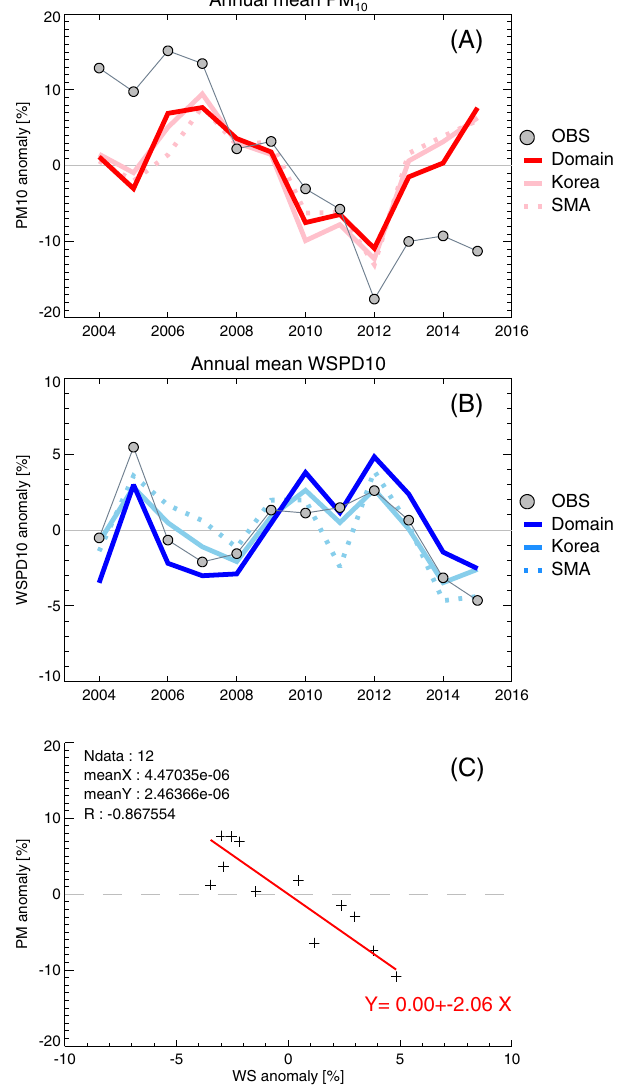
Figure 2. Normalized anomalies of annual mean surface PM concentration ( A ), and annual mean 10-m wind speed ( B ). Red (blue), pink (light blue), and dashed pink (light blue) lines indicate anomalies of modeled PM concentrations averaged over the 9-km domain-wide, Korea (land pixels), and the SMA regions for PM concentrations (for wind speed). Circles indicate observations of surface PM concentrations (247 sites over South Korea) and wind speed (79 sites over South Korea). The scatter plot ( C ) shows a least square regression fit between normalized anomalies of surface PM concentrations and wind speed from the model (9-km domain